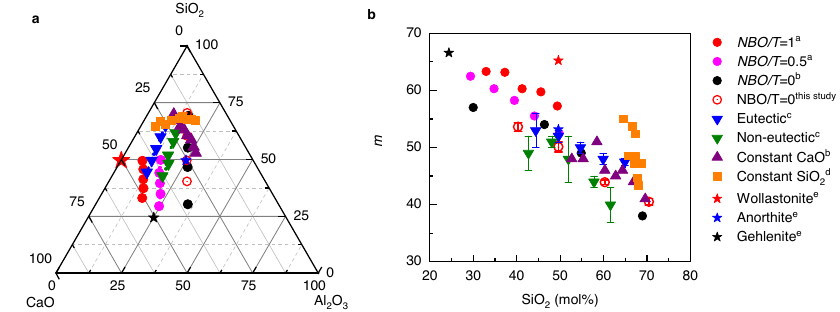
Fig. 1 | Inverse correlation between m and SiO 2 mol% of Group I ’ s 48 CAS glasses. a Compositions of 44 CAS glasses with published fragility values and 4 glasses with fragility index measured in this study, as shown in the ternary phase diagram in mol%. b An inverse correlation between m and SiO 2 mol% of 48